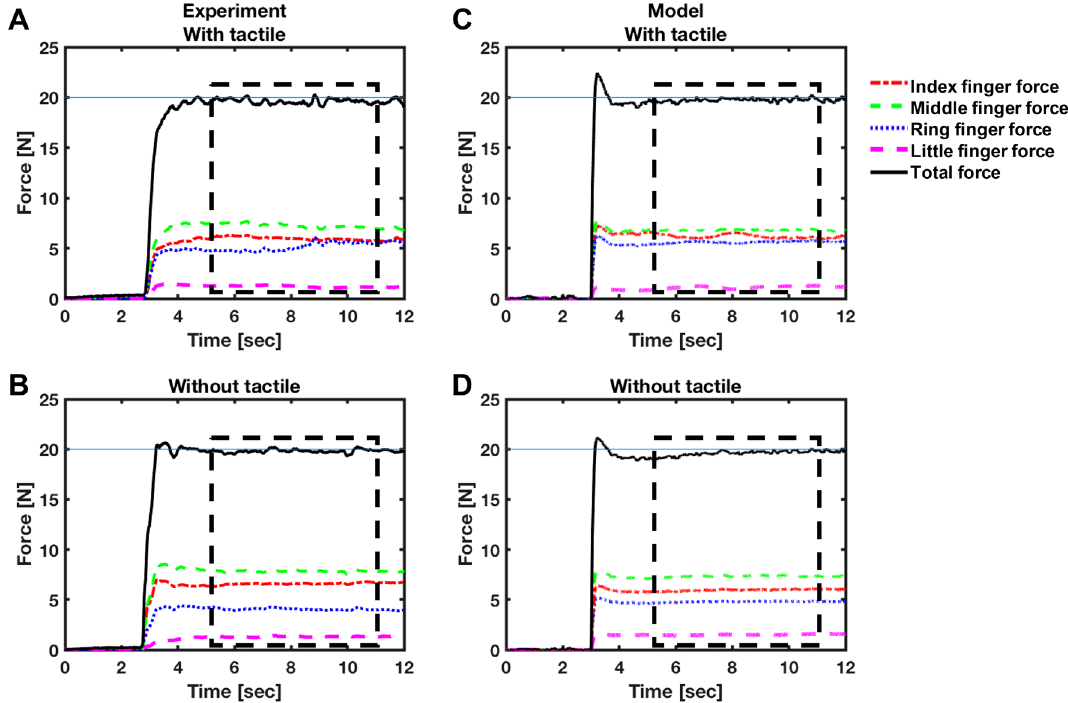
Figure 3. Experimental and simulated finger force trajectories for two trials. Human-subject experimentally- generated finger forces in ( A ) with tactile and ( B ) without tactile feedback, respectively. Simulated finger force trajectories for randomly generated human-subject parameters ( C ) with tactile and ( D ) without tactile feedback. The black line shows the sum of all finger forces. Each finger force is shown with a designated color. The dashed line shows the 5 s window where the total force remains stationary, which is the part of data for our HVD analysis. We use this part of data for our